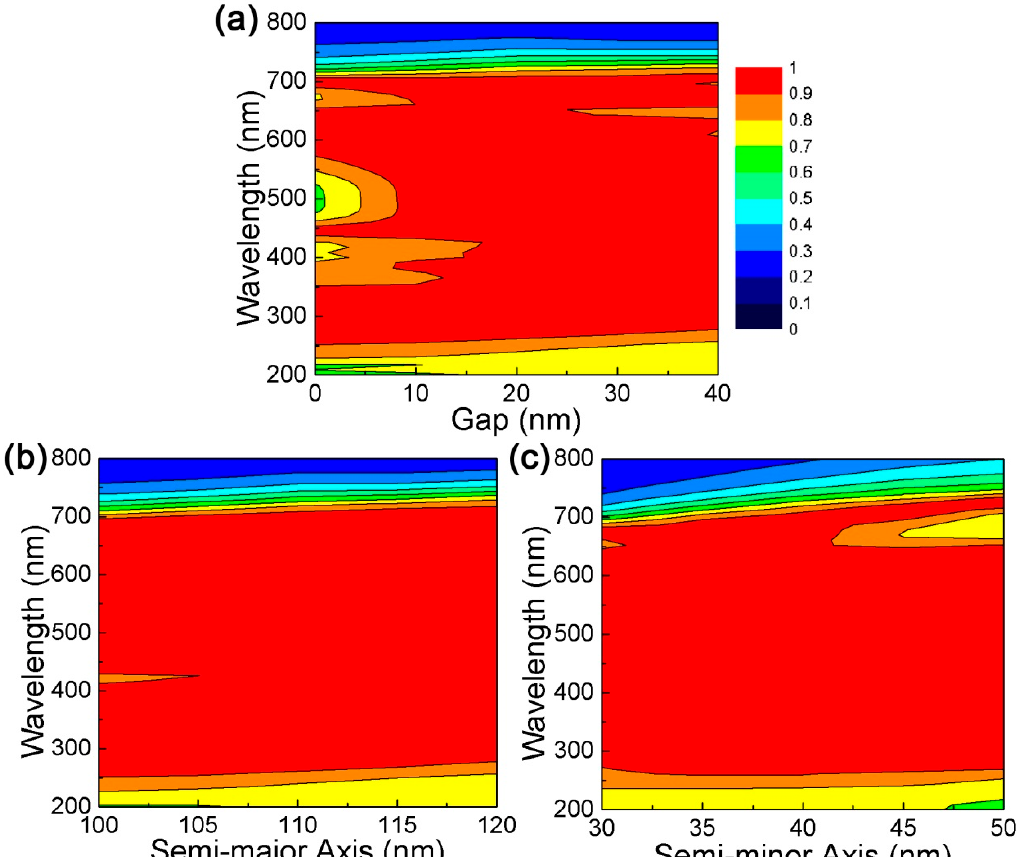
Figure 5. Tunable DBMPA is obtained by changing the structure parameters. ( a ) the gap increases from 0 to 40 nm; ( b ) the change of the absorption spectrum caused by the change of semi-major axis (a) of the resonator; ( c ) the change of the absorption spectrum caused by the change of semi-minor axis (b) of the resonator from 30 to 50 nm.